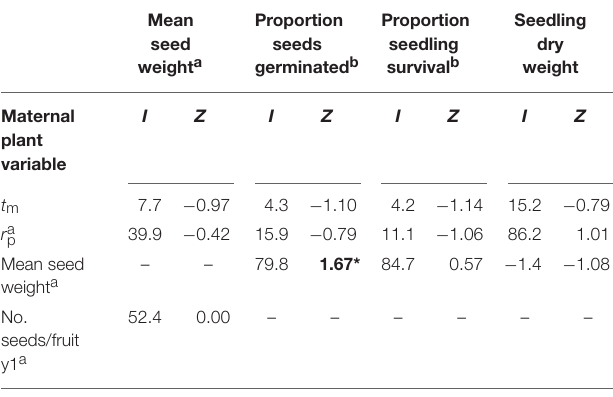
TABLE 9 | The percentage independent contribution ( I ) of each of two mating system and two reproductive variables to variation in measures of progeny performance for maternal Eucalyptus wandoo plants, determined by hierarchical